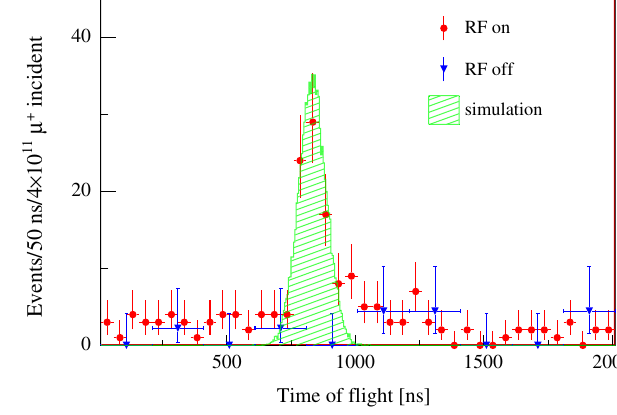
FIG. 4. TOF spectra of the negative-charge configuration with rf on and off. The clear peak of the rf on spectrum at 830 ns corresponds to the accelerated Mu − ’ s. The error bars are statistical. A simulated TOF spectrum of the accelerated Mu − ’ s is also